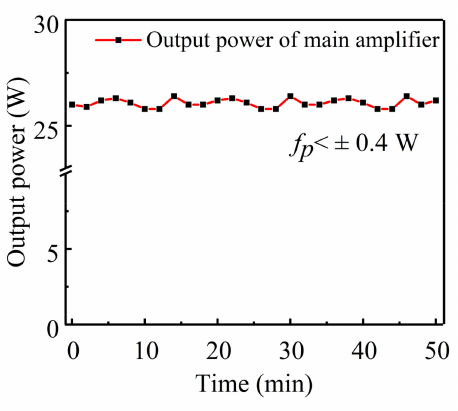
Figure 8. Output power stability of the main amplifier for 50 min.